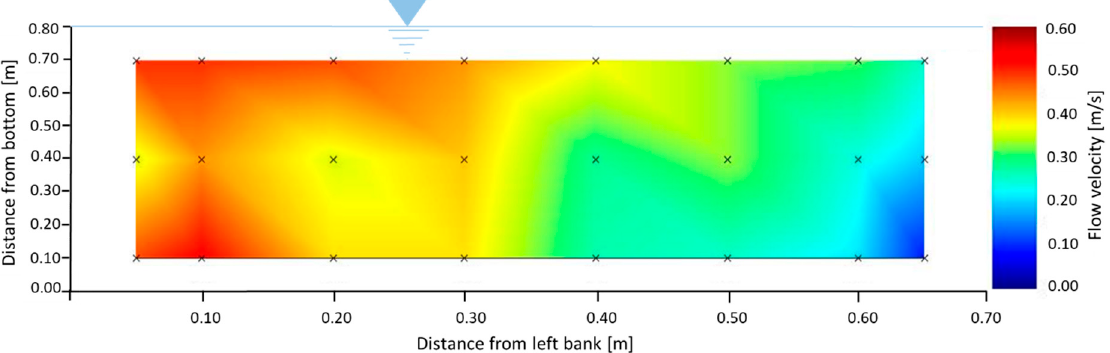
Figure 2. Flow velocity distribution [m/s] 0.15 m upstream of the Bar Rack FishProtector in a vertical plane looking in flow direction; x -axis: distance from orographic left-hand side [m], y -axis: distance from channel bottom [m], low flow velocities represented in blue, higher velocities in red. Measuring locations indicated with black crosses. Increased velocities at the left bank.